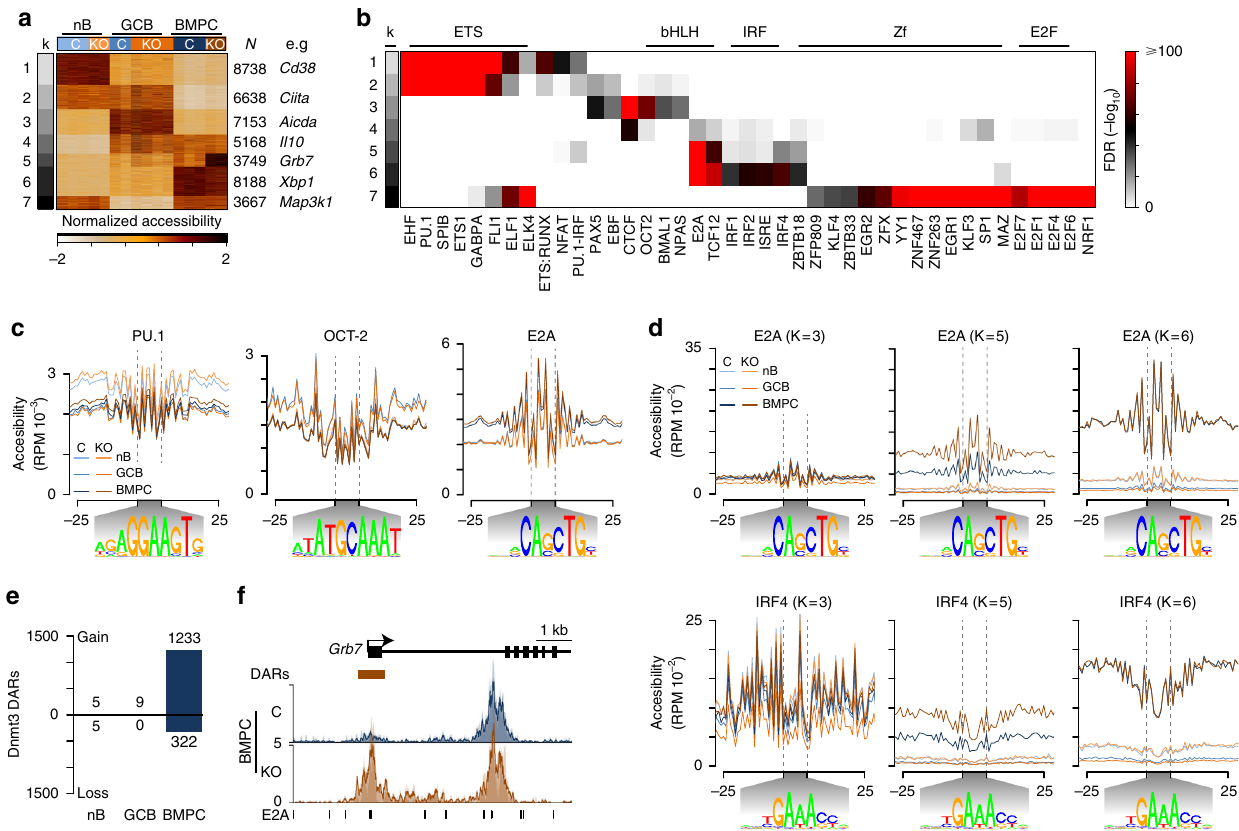
Fig. 5 Increased chromatin accessibility in Dnmt3-de fi cient CD138 + BMPC. a K-means clustering of differential ATAC-seq peaks in B220 + GL7 − Fas − naive B cells (nB), B220 + PE + GL7 + Fas + PE-speci fi c germinal center B cells (GCB), and CD138 + BMPC in Cd19 cre/ + Dnmt3a fl / fl Dnmt3b fl / fl (KO) and littermate control (C) mice. The number of peaks in each cluster is denoted on the right. b Enrichment of HOMER transcription factor binding motifs in different K- means clusters shown in a . c Accessibility footprinting of ATAC-seq data shown for all PU.1, OCT-2, and E2A binding motifs genome-wide. Motifs are shown below. d Accessibility footprinting at E2A (top) and IRF4 (bottom) binding motifs that fall in speci fi c K-means regions. e Number of differentially accessible regions (DARs) between Dnmt3-de fi cient (KO) and -suf fi cient (C) mice for nB, GCB, and BMPC. f Genome plot of regions containing differentially accessible regions (DARs) around Grb7 . E2A transcription factor bind motifs are shown below. Data were derived from 3 experiments and 22 mice, where nB were isolated from 5 mice, GCB were from 12 mice (2 mice were pooled per sample), and BMPC were from 5 mice. Mice were either all male (nB), 4 female and 2 male split between the genotypes (GCB), or all female